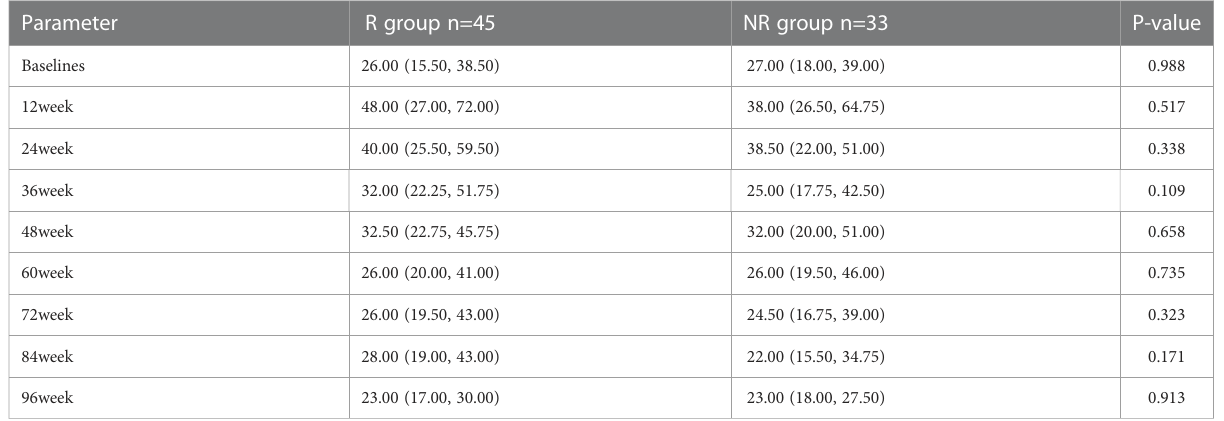
TABLE 3 ALT level at baseline and during treatment.